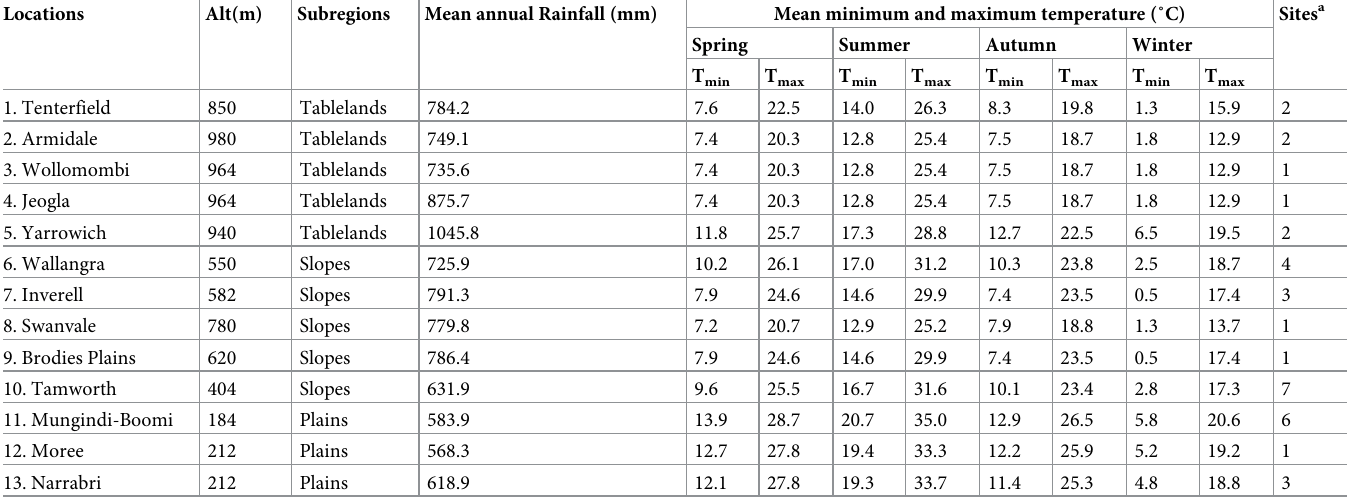
Table 1. Details on the locations and climate data during Culicoides trappings from 1990 to 2018 in the New England region of NSW, Australia.